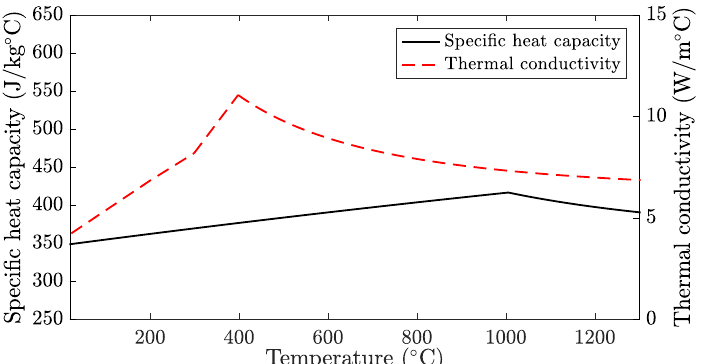
Figure 2. Thermal material data used in the simulations based on Lindwall et al. [17], Heinrich et al. [24] and Lindwall et al.